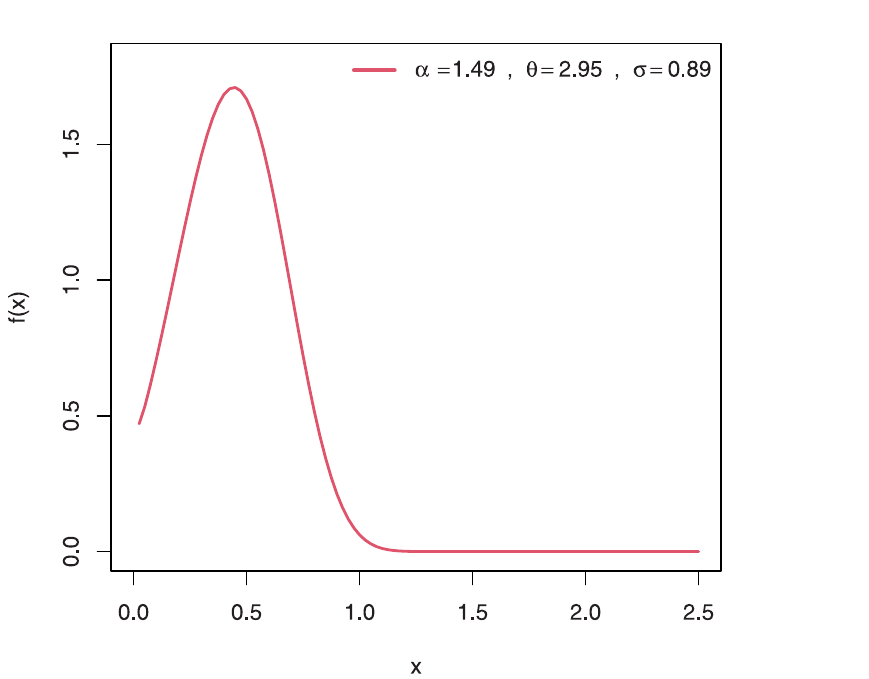
Fig 4. Plots of EGuNH density for a variety of parameter combinations.